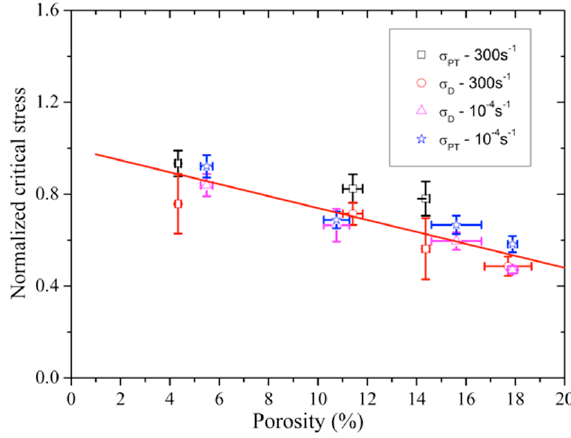
Figure 11. The normalized σ D and σ P versus porosity.